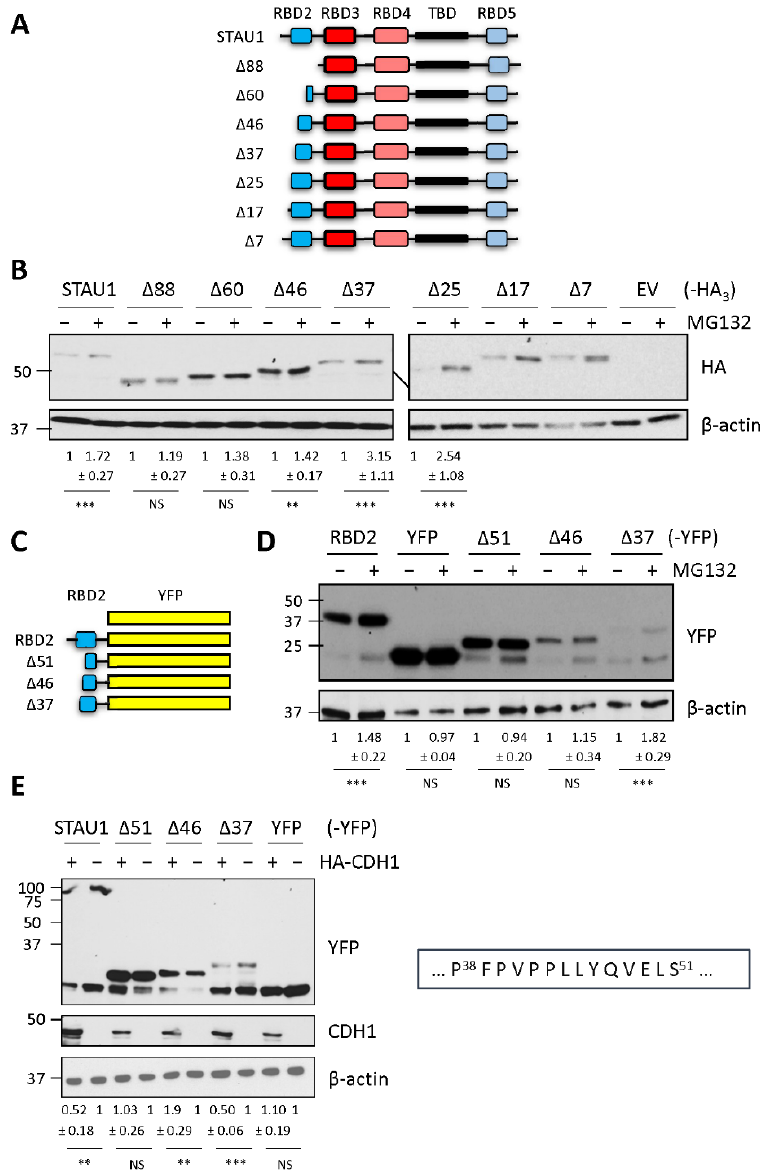
Figure 2. The degradation motif is located within amino acids 38 and 51. ( A ) Schematic representation of STAU1 55 and mutants with progressive deletions of the first N-terminal 88 amino acids (see legend in Figure 1). ( B ) Plasmids coding for STAU1 55 -HA 3 or deletion mutants were transfected in HEK293T cells. After 24 h, cells were treated with 20 µ M MG132 for 8 h (+). Protein extracts were analyzed by Western blotting using anti-HA antibody. ( C ) Schematic representation of RBD2 and the deletion